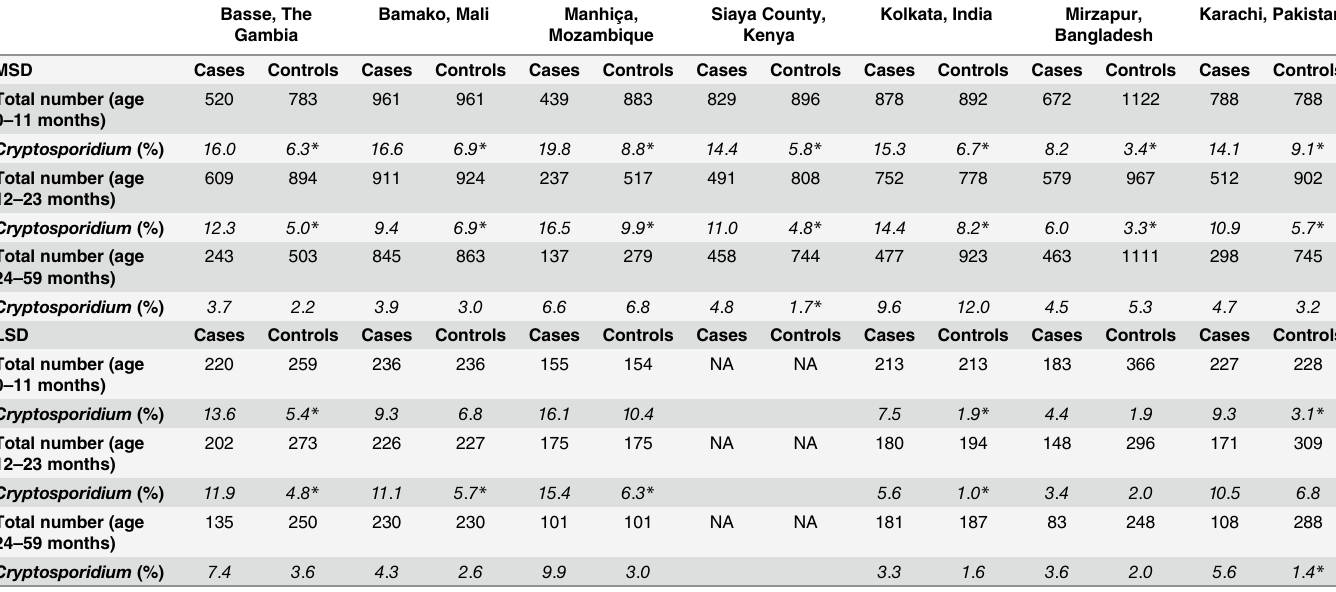
Table 1. Cryptosporidium positivity (by EIA) in cases and controls by age, site, and severity of diarrhea. Basse, The Gambia Cases Controls Cases Controls Cases Controls Cases Controls Cases Controls Cases Controls Cases Controls